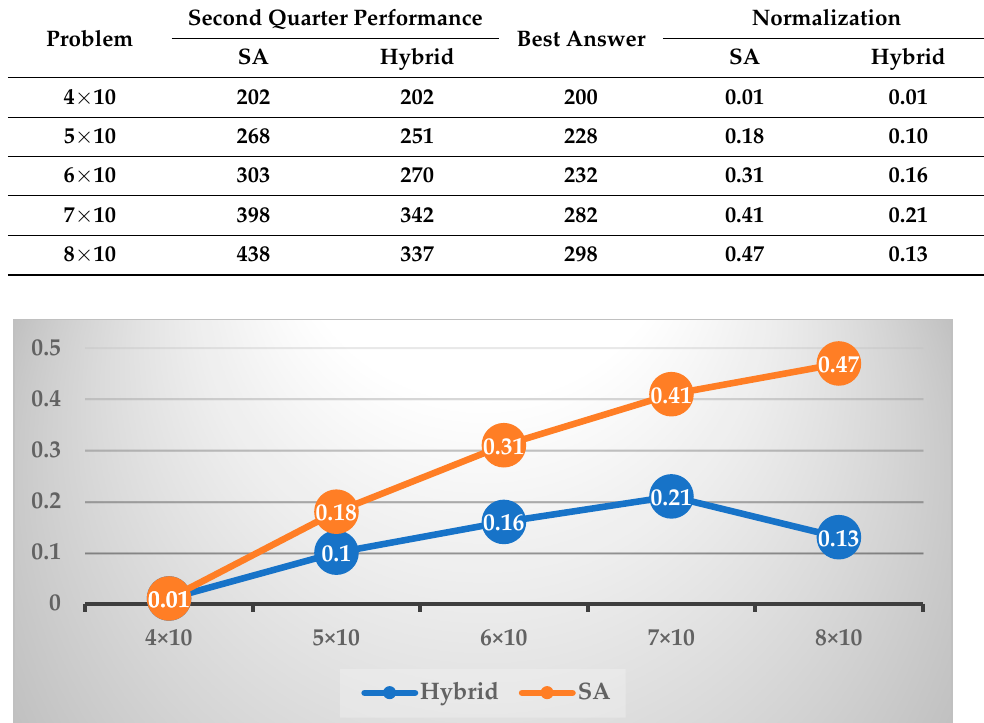
Figure 15. Fitness diagram of SA and hybrid SA in the second quarter (10 ORs). Table 6. Results of executing the SA and hybrid SA algorithms in the second quarter (15 ORs) . Problem